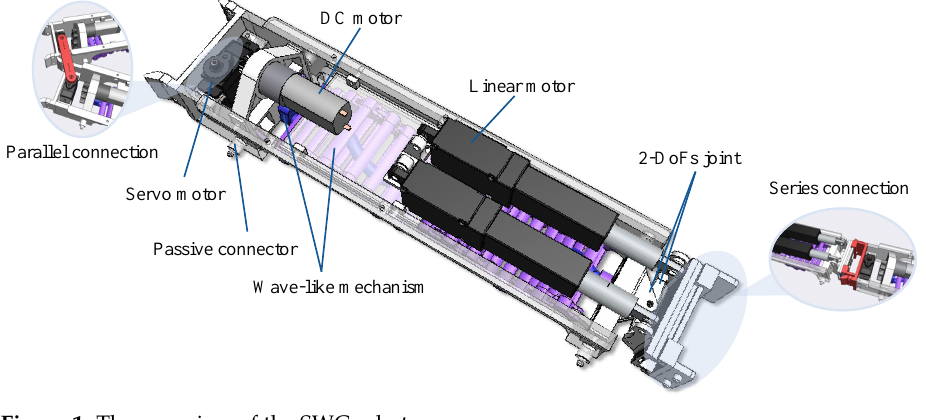
Figure 1. The overview of the SWC